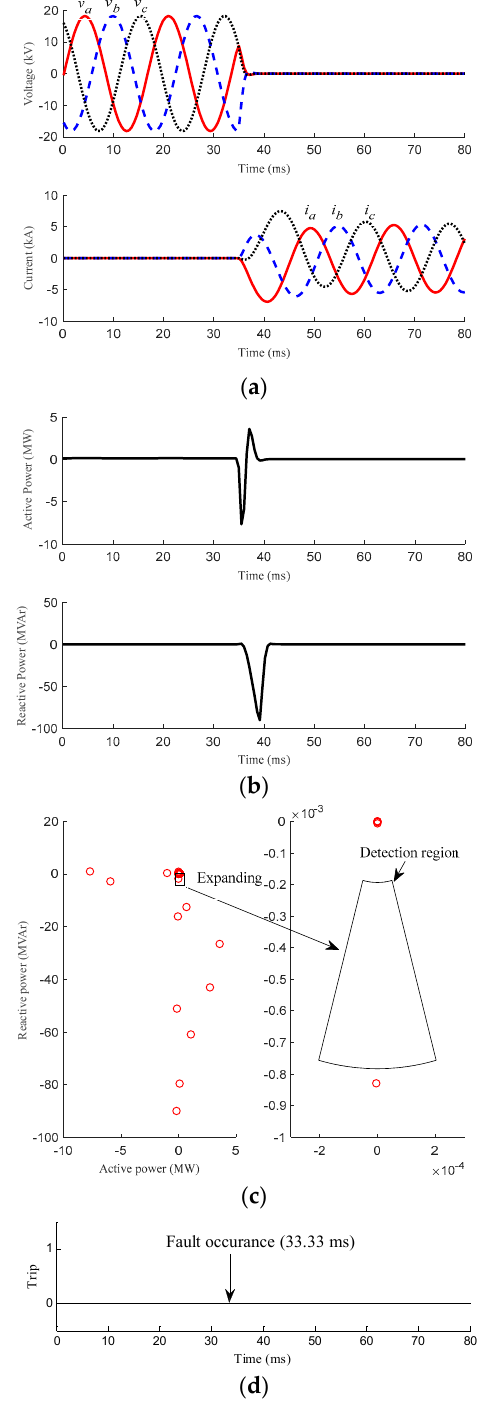
Figure 8. Results for Case 6. ( a ) v a , b , c (upper) and i a , b , c (lower); ( b ) p 3 ph (upper) and q 3 ph (lower); ( c ) Trajectories of the point ( p 3 ph , q 3 ph ); ( d ) Islanding detection signal.